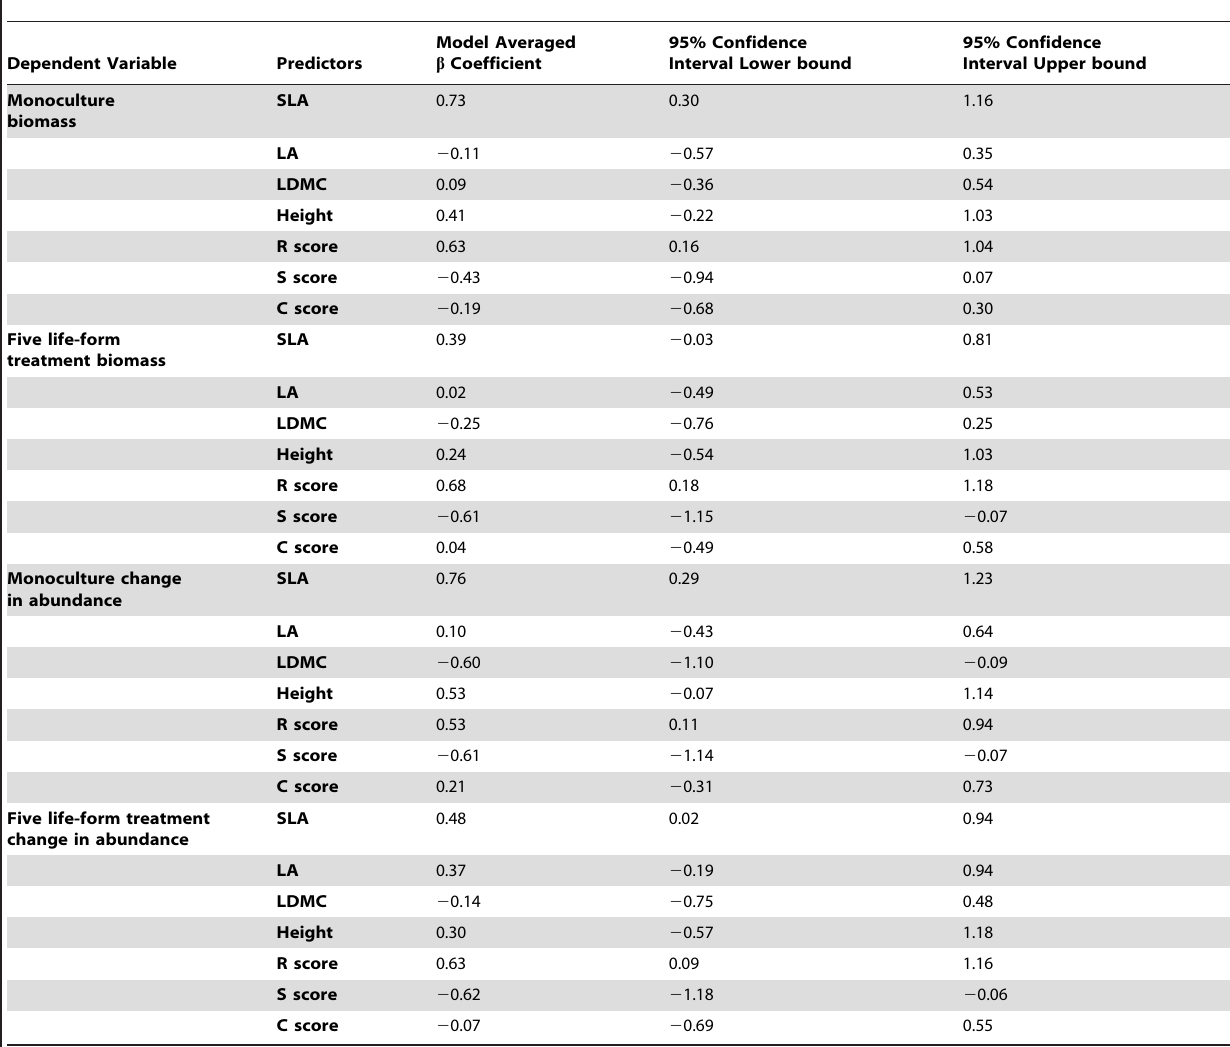
Table 3. Multiple linear regression showing standardized coefficients from model averaging for final biomass and change in abundance in monoculture and five life-form